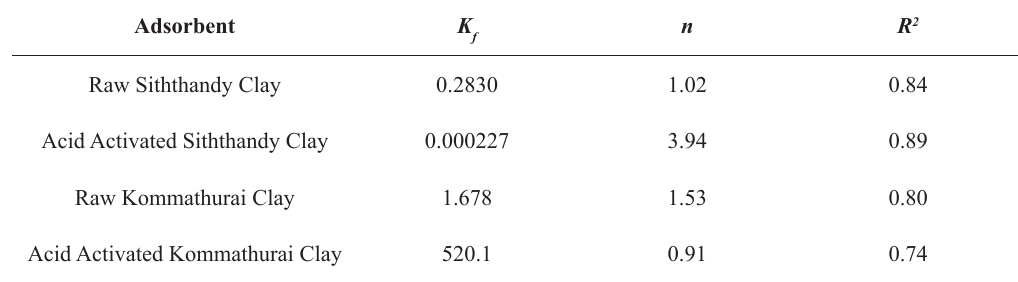
Table 3: Freundlich adsorption isotherm constant for CR. Adsorbent